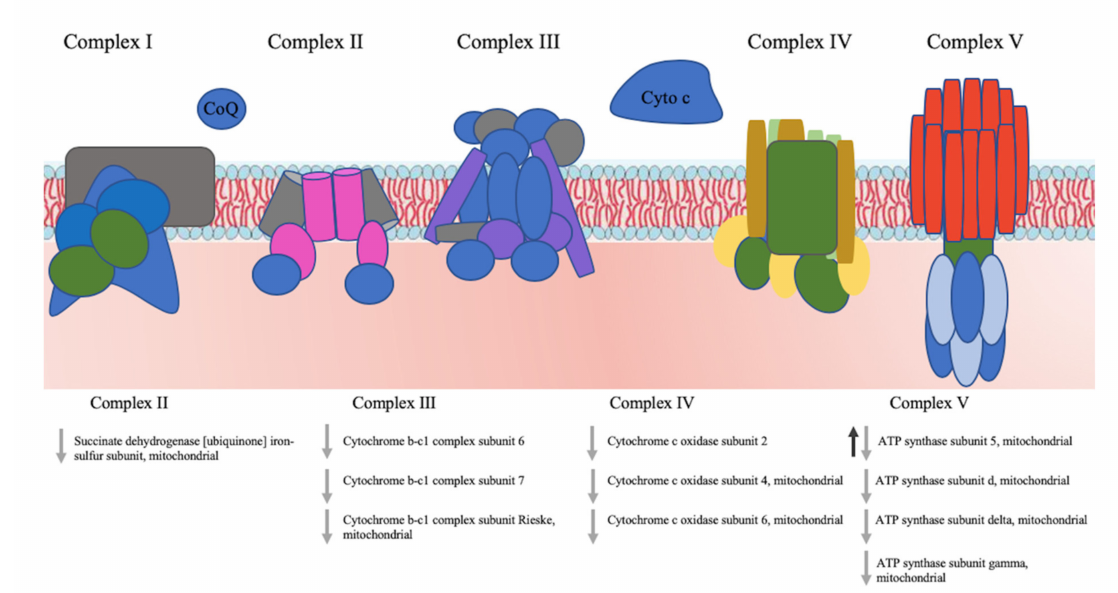
Figure 8. Oxidative phosphorylation pathway. Black arrows are for the proteins found with iTRAQ after 9 h treatment, grey arrows are for the proteins found after 24 h treatment. Arrows pointing up indicate upregulated proteins, arrows pointing down indicate downregulated